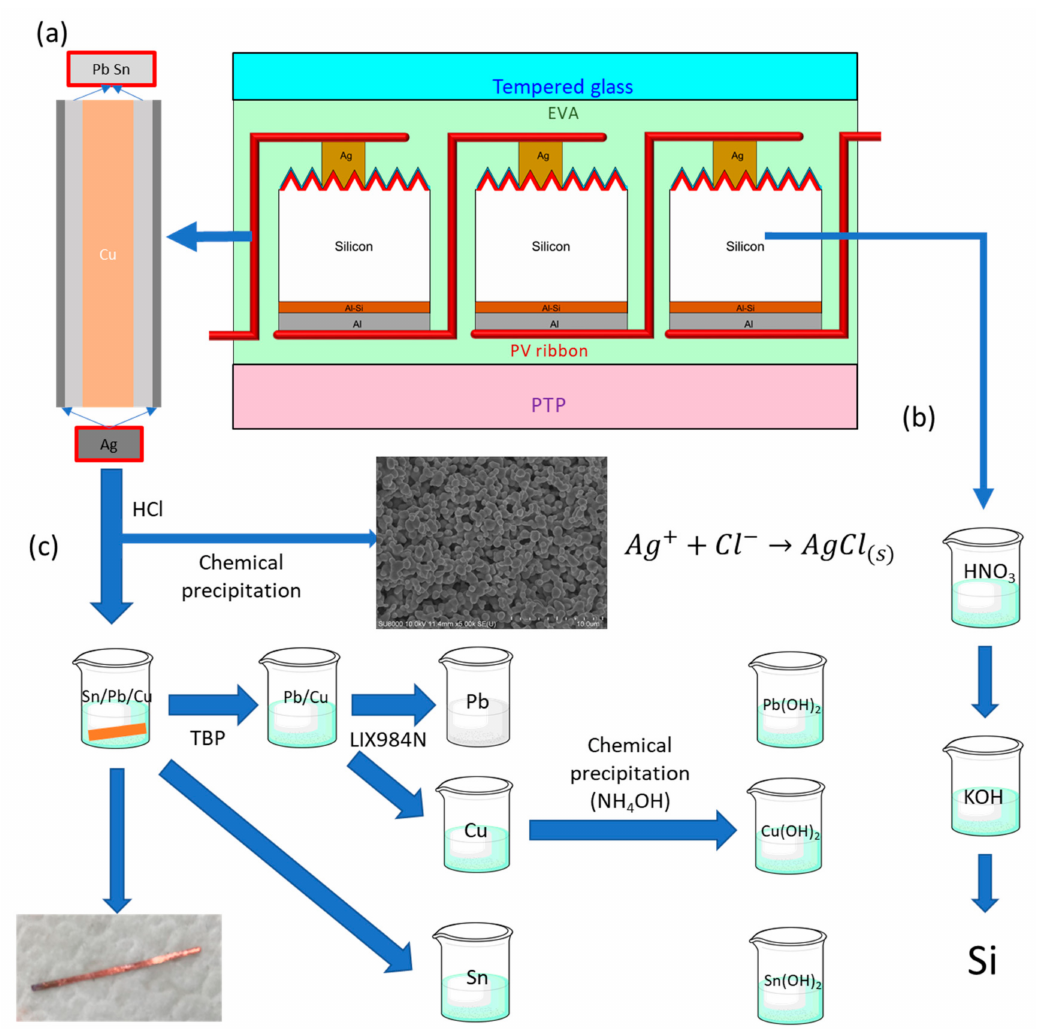
Figure 1. Method for recovering PV cells and PV ribbons. ( a ) Section views of c-Si PV module and the PV ribbon. ( b ) Immersing cells in nitric acid and potassium hydroxide for silicon purification. ( c ) Pretreatment and metal separation of PV